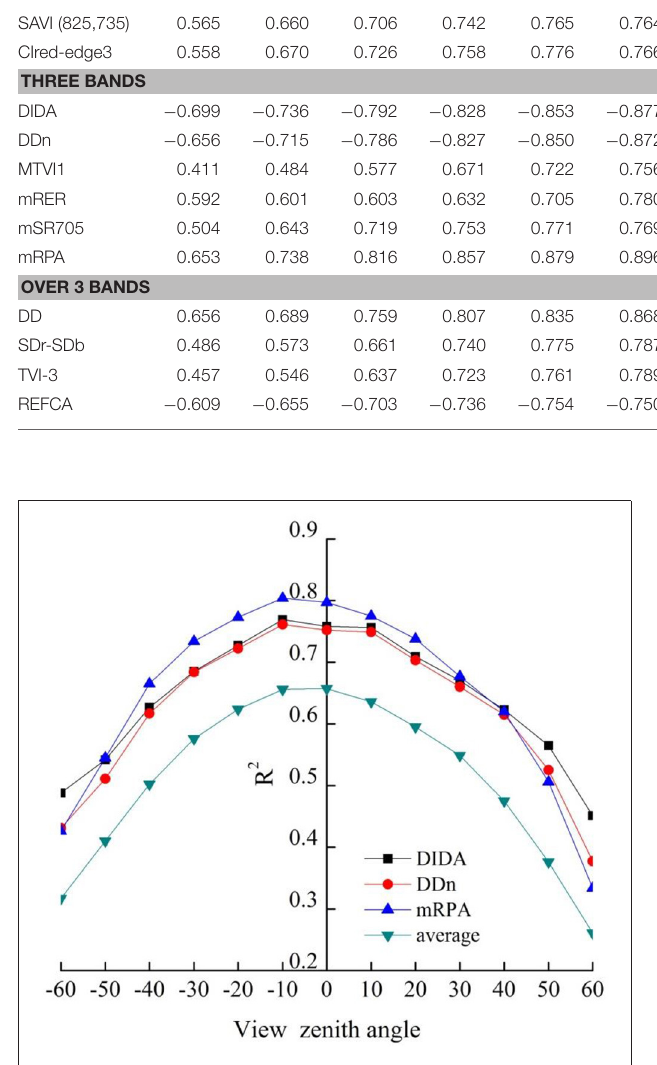
FIGURE 8 | Relationship between aerial N uptake and DIDA, DDn, mRPA, and average (corresponding average value of 18 VIs at different VZAs, shown as average) at different VZAs ( n = 155, p 0.001 = 0.262).